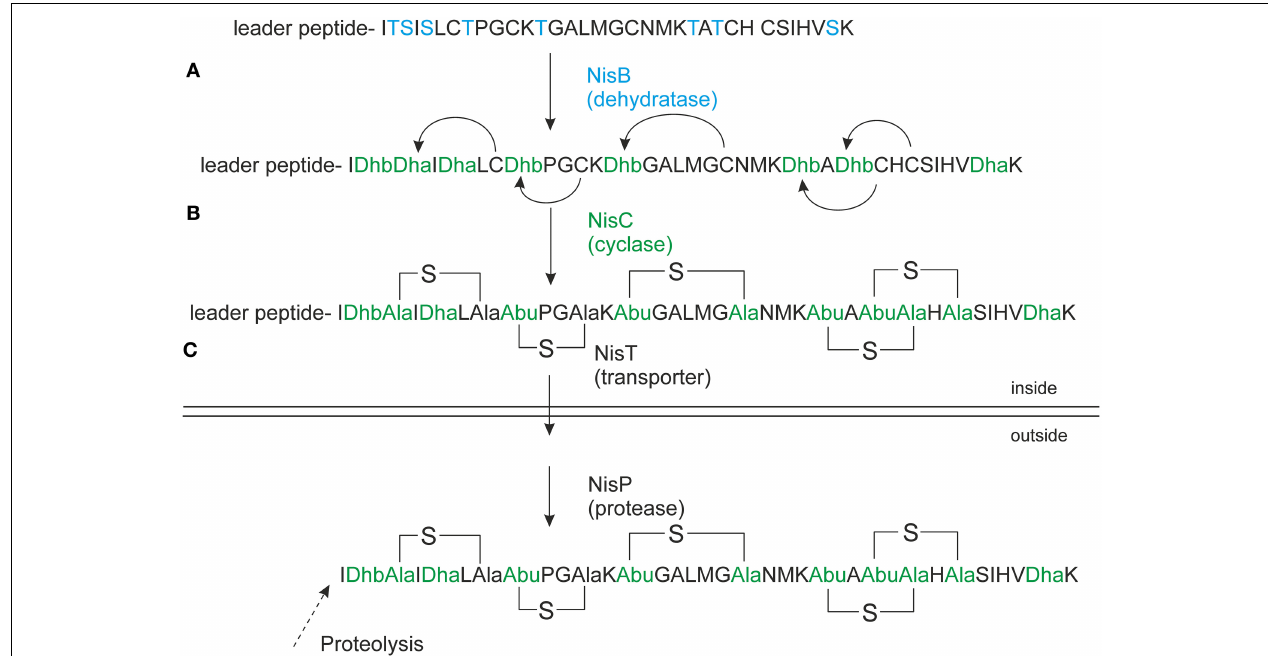
FIGURE 1 | Nisin biosynthesis. NisA is ribosomally synthesized in a form of precursor nisin. (A) NisB dehydrates underlined Ser/Thr’s (in bold), the resulted dehydrated precursor nisin contains dehydroalanines (Dha) and dehydrobutyrines (Dhb); (B) NisC forms thioether bridges between dehydrated residues and cysteines resulting in fully modified precursor